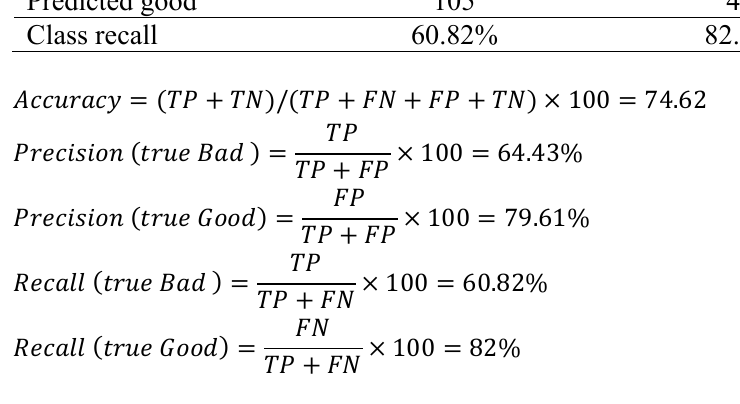
The results of the implementation of KNN Truly bad Truly good Class precision Predicted bad 163 Predicted good